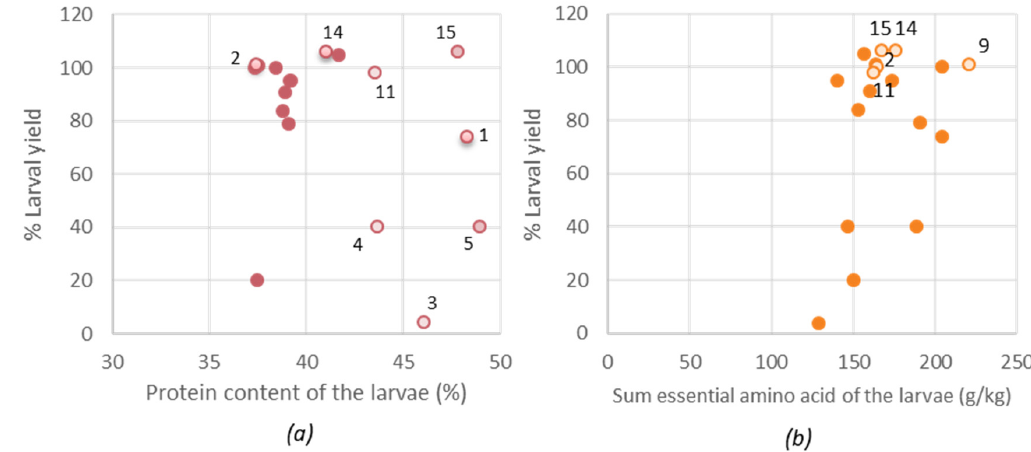
Figure 5. ( a) The relation between the larval protein and the larval yield, ( b ) The relation between the larval essential amino acid (EAA) content and the larval yield. Hollow bullets were indicated by their diet number. Diet 2 = reference